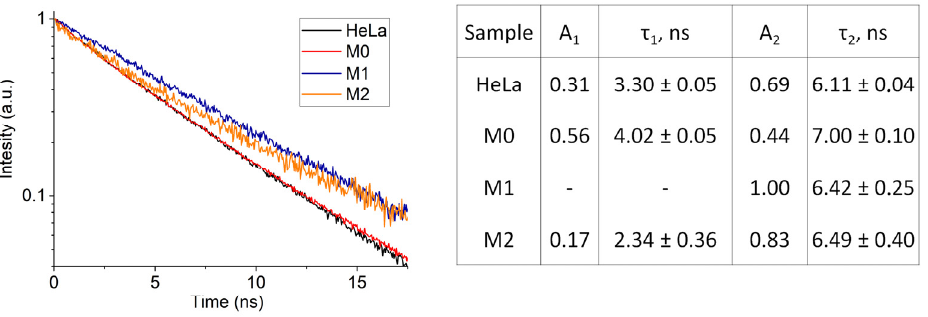
Figure 6. Fluorescence kinetics of AlPc NPs upon interaction with M0, M1 and M2 macrophages calculated fluorescence lifetimes and amplitudes. and calculated fluorescence lifetimes and amplitudes.